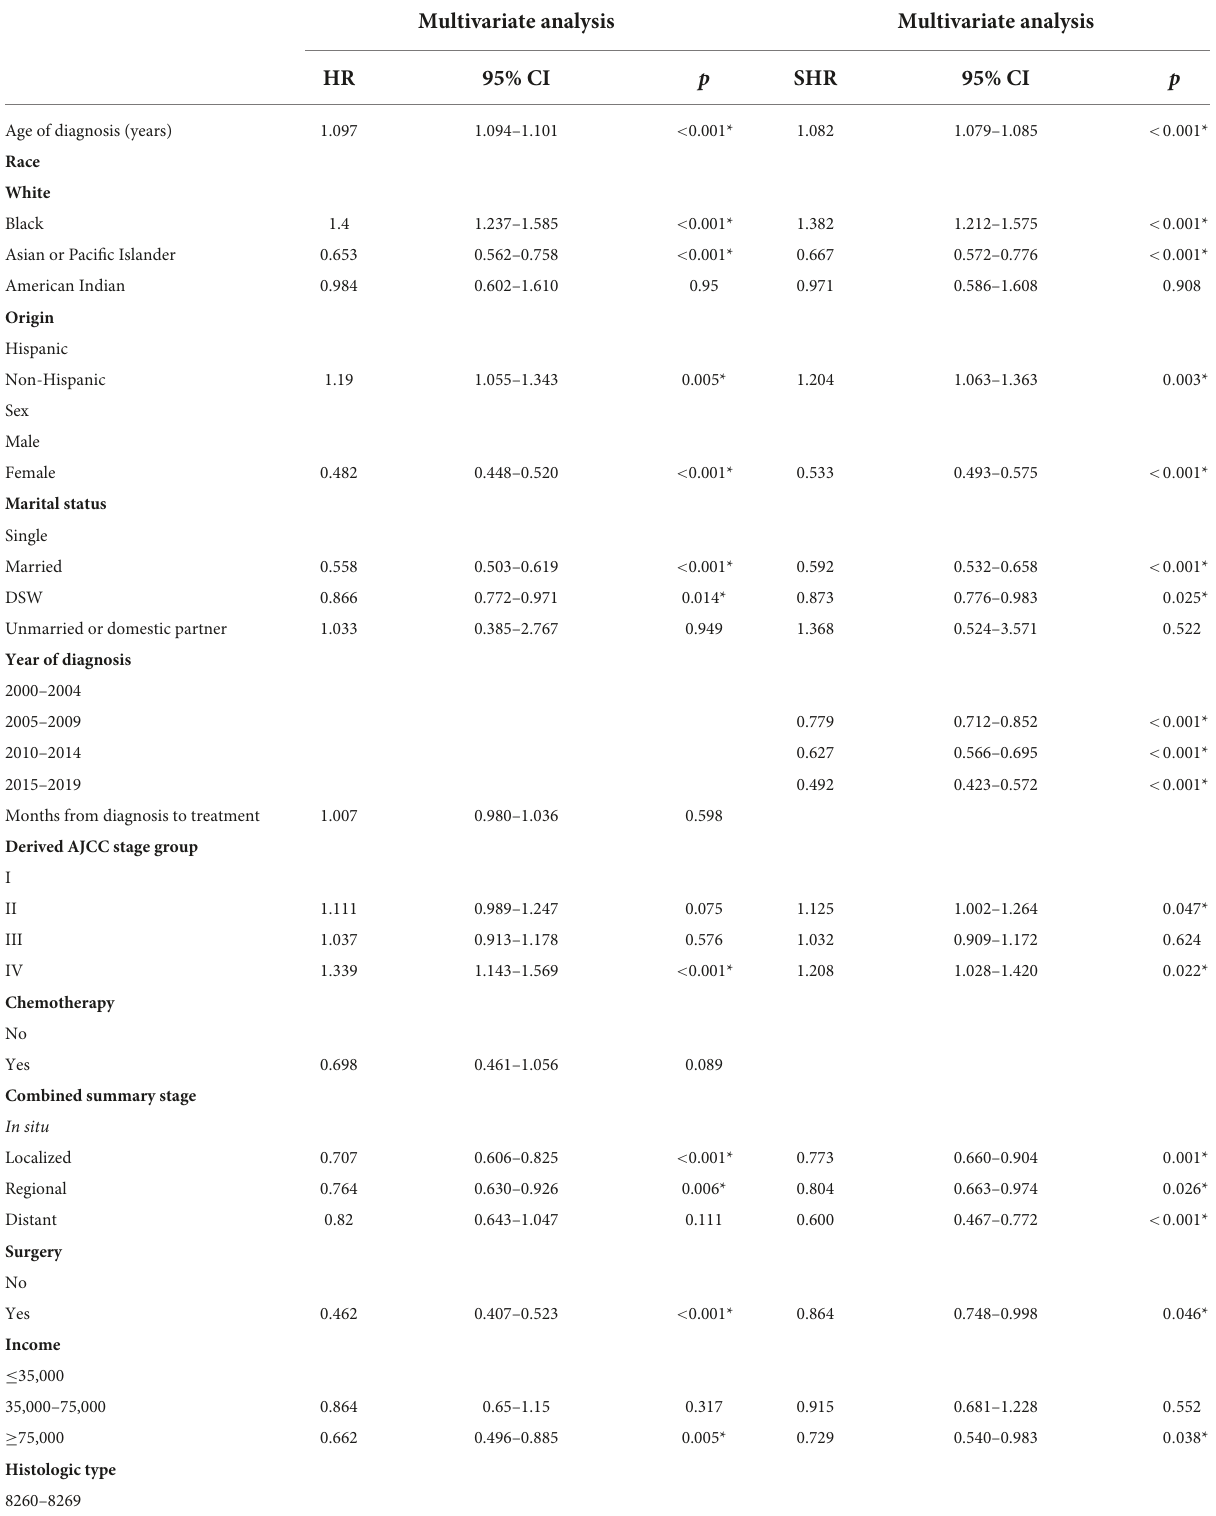
TABLE 2 Multivariate regression analyses before propensity score